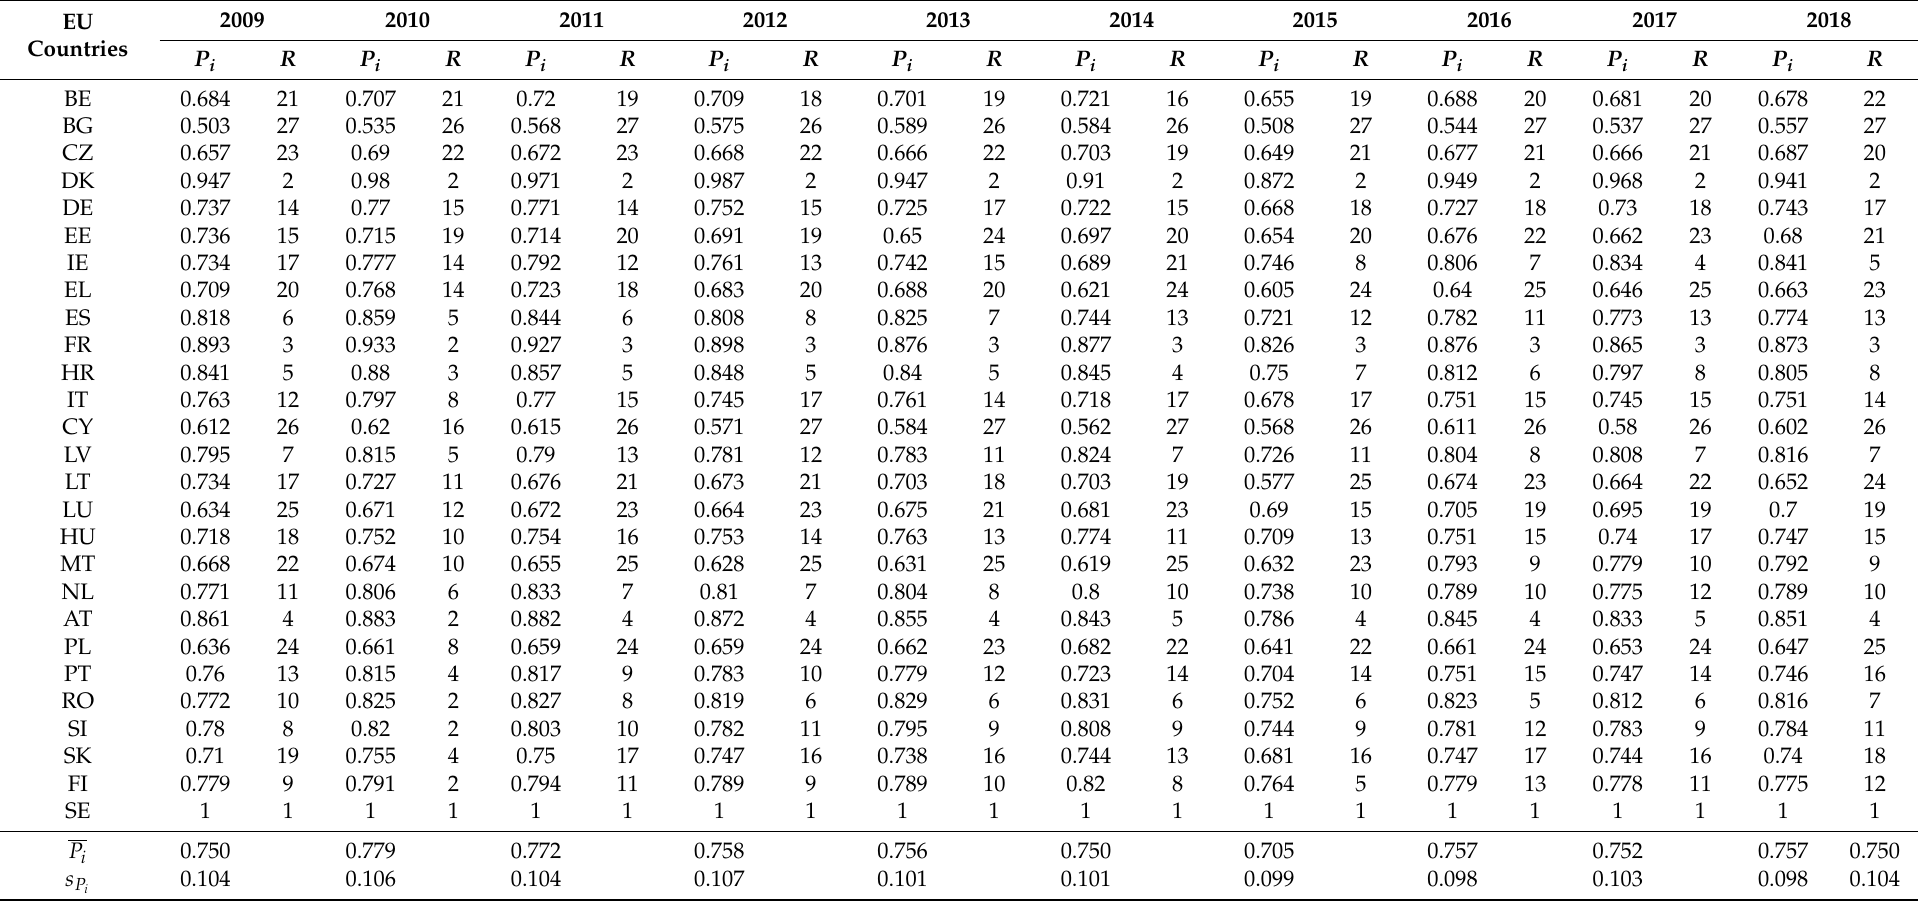
Table 2. The value of the P i index of sustainable development for the EU countries between 2009–2018 and the ranking ( R ) of the EU countries. EU